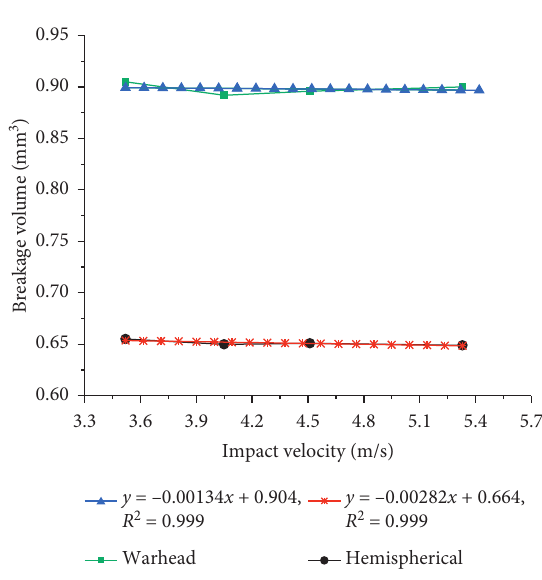
Figure 15: Rock breakage volume versus impact